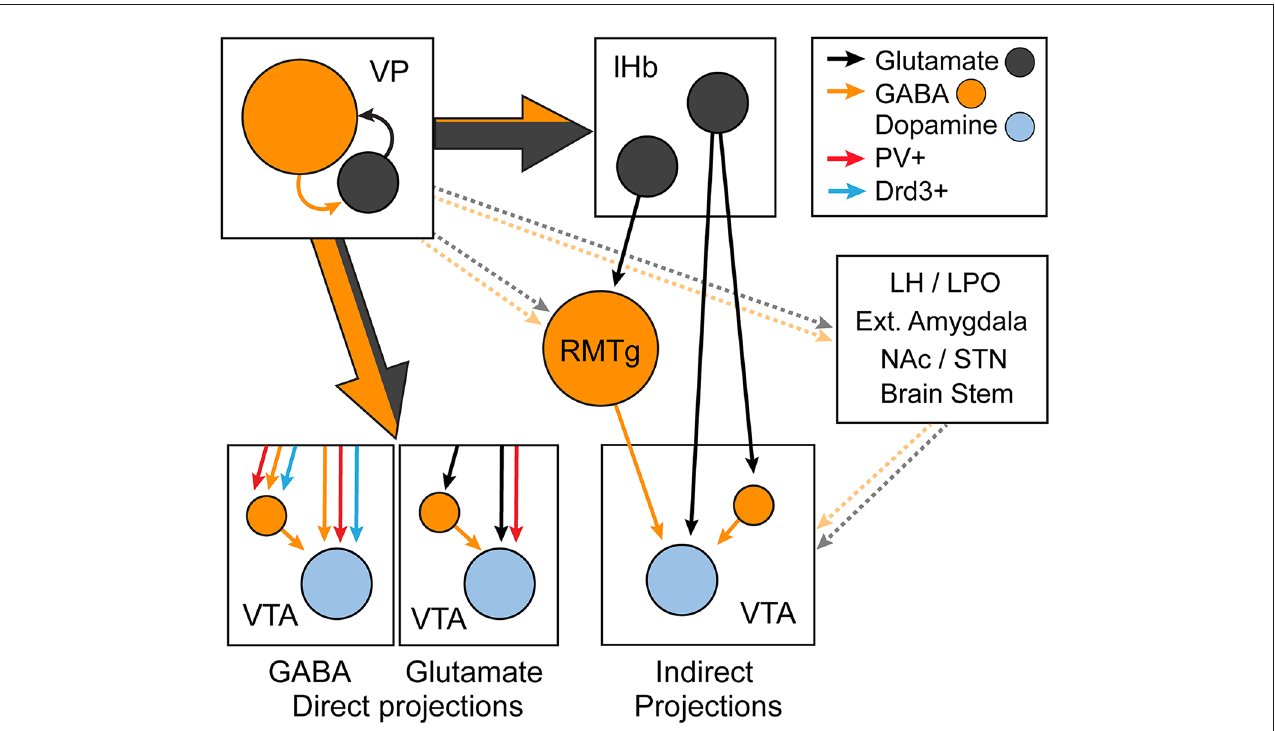
FIGURE5 Diagram summarizing the direct and indirect regulation of ventral tegmental area (VTA) dopamine neurons by different subpopulations of VP neurons. The direct VP-VTA projection is predominantly glutamatergic, and the indirect VP to lateral habenula (lHb) to VTA projection is mostly glutamatergic. GABAergic VP-VTA projections include parvalbumin (PV) and dopamine D3 receptor (Drd3) positive projections and equally innervate VTA dopamine and GABA neurons. Glutamatergic VP-VTA neurons are either PV positive or negative, and PV-positive projections preferentially target dopamine neurons. lHb neurons that are innervated by the VP project directly to the VTA, and indirectly inhibit dopamine neurons through the rostromedial tegmentum (RMTg). Other targets through which VP neurons influence dopamine neuron activity include the lateral hypothalamus (LH) and preoptic area (LPO), extended amygdala, nucleus accumbens (NAc), and subthalamic nucleus (STN) and brain stem nuclei. Dotted lines indicate uncharacterized and hypothesized